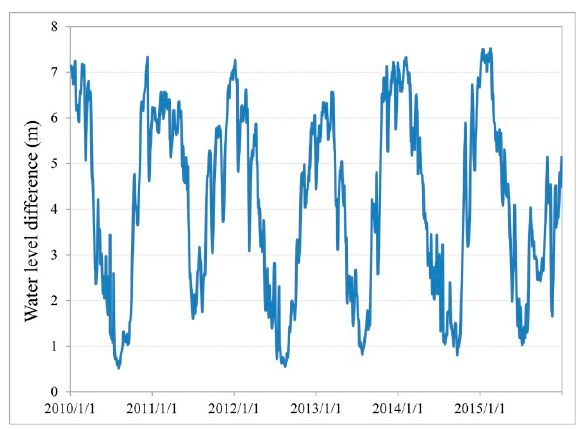
ff erences between West and East Dongting Figure 7. Daily water level differences between West and East Dongting lakes. Figure 7. Daily water level di